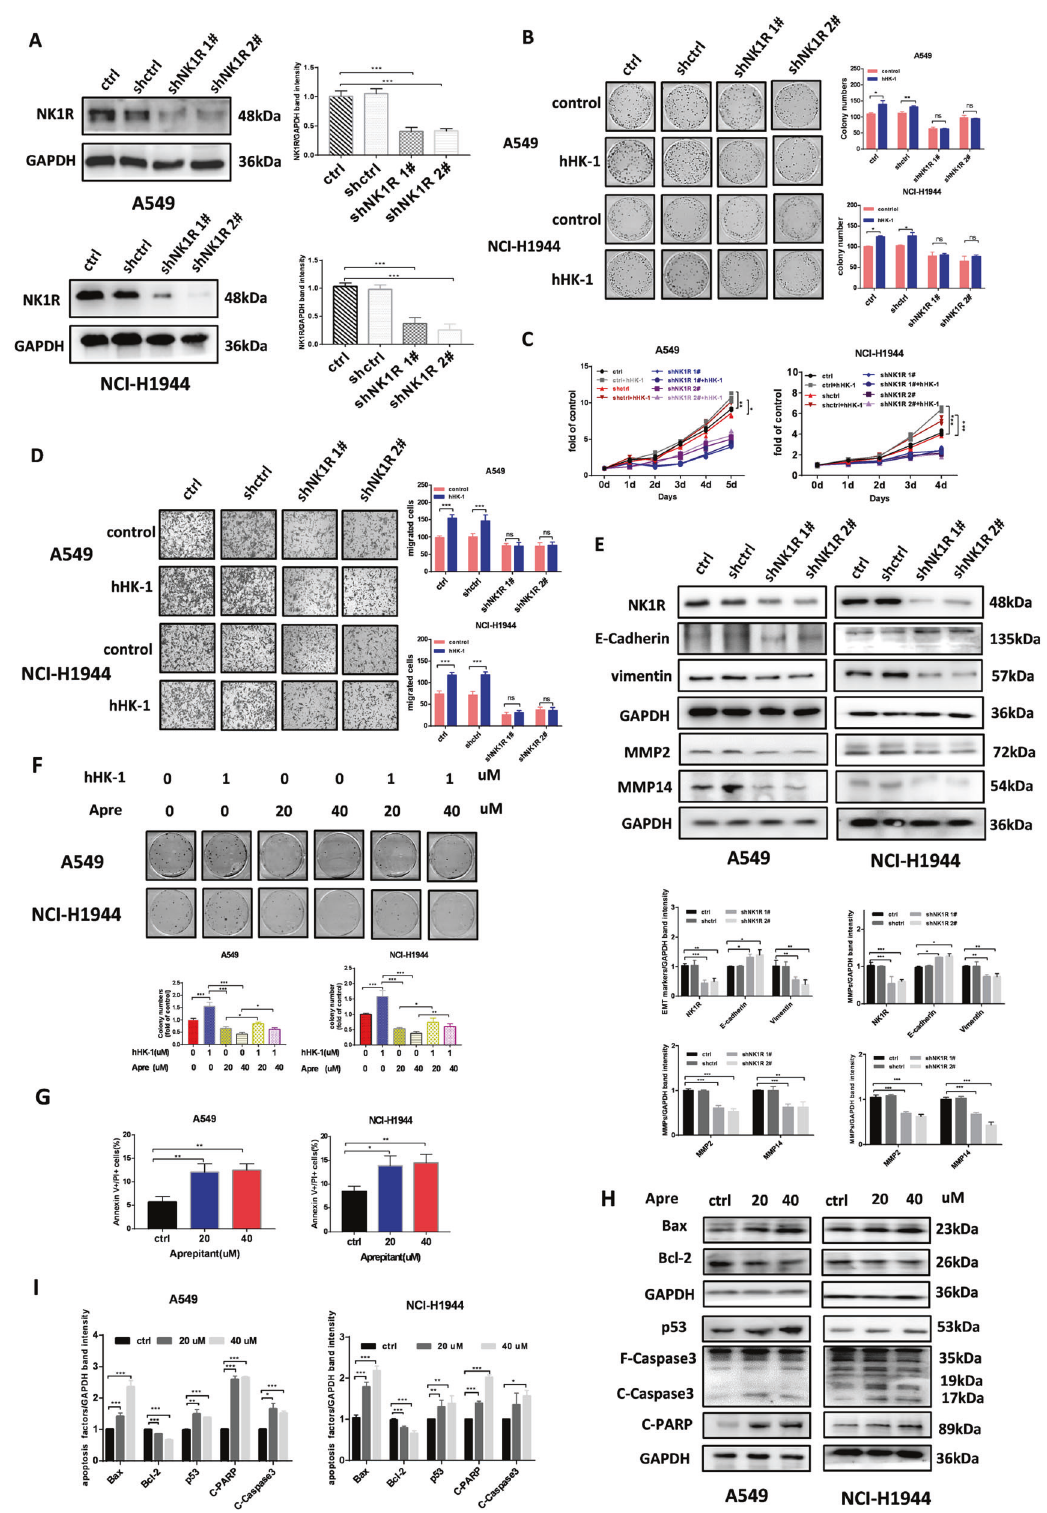
Fig. 3 Inhibition of NK1R suppresses NSCLC cell progression in vitro. A Western blot analysis of NK1R expression in NSCLC cells transiently transfected with shRNA targeting NK1R or control shRNA. The effect of shRNA-mediated NK1R knockdown on B NSCLC cell colony formation (colonies larger than 0.1mm in diameter were counted), C cell growth curve, D transwell cell migration, and E E-cadherin/vimentin, MMP2/14 protein expression. F Aprepitant inhibited the ability of cell colony formation stimulated by hHK-1. Aprepitant treatment induced NSCLC cell apoptosis measured by G fl ow cytometry analysis of PI/Annexin V co-staining and H western blot analysis of p53, Bax, Bcl-2, caspase3, cleaved-PARP protein level. I Band intensity of the p53, Bax, Bcl-2, caspase3, cleaved-PARP protein. migrated cell number, and densitometric analysis of each band were calculated with Image J software. Data were shown as mean ± SD from three independent experiments. * P < 0.05, ** P <0.01, *** P <0.001.